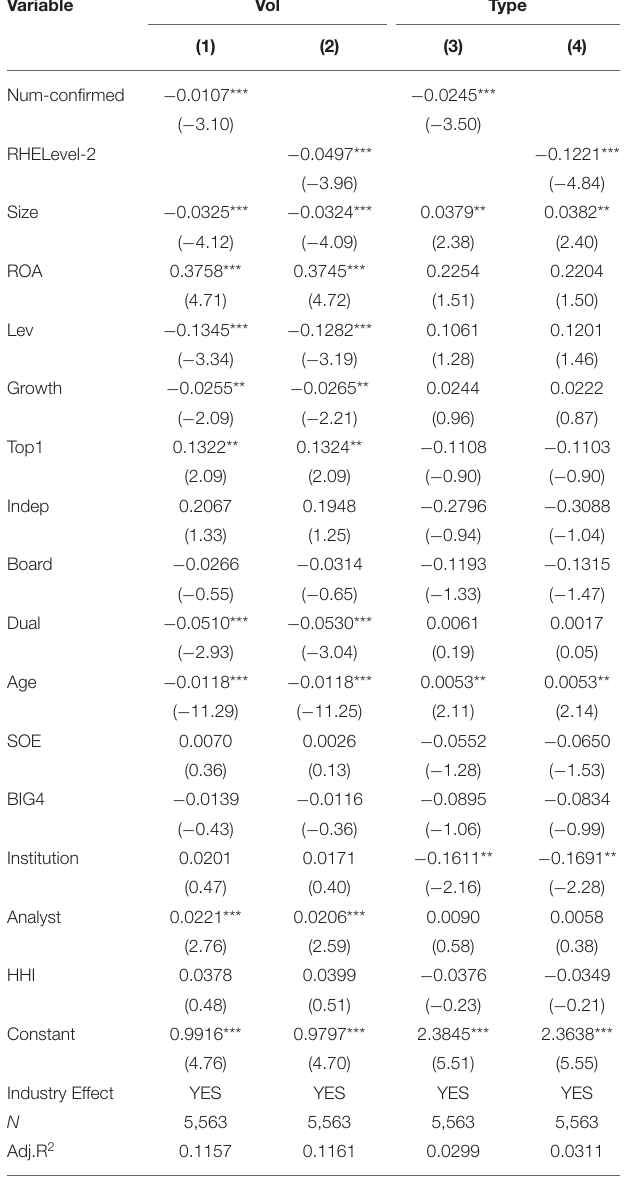
TABLE 14 | Impact of COVID-19 on the management’s earnings forecast disclosure.